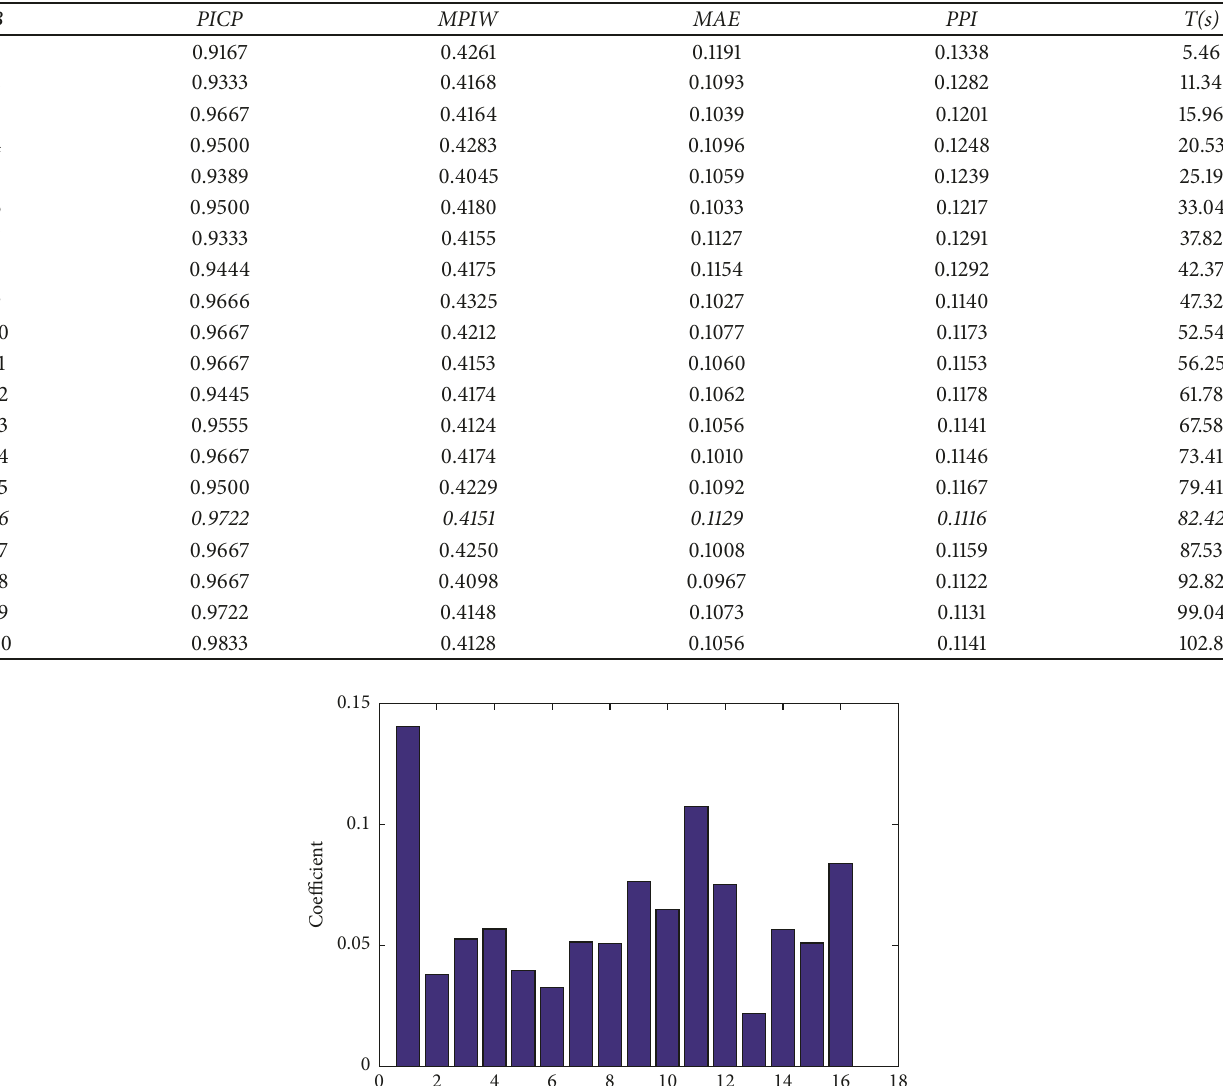
Table 2: The validation result of the number of local networks.